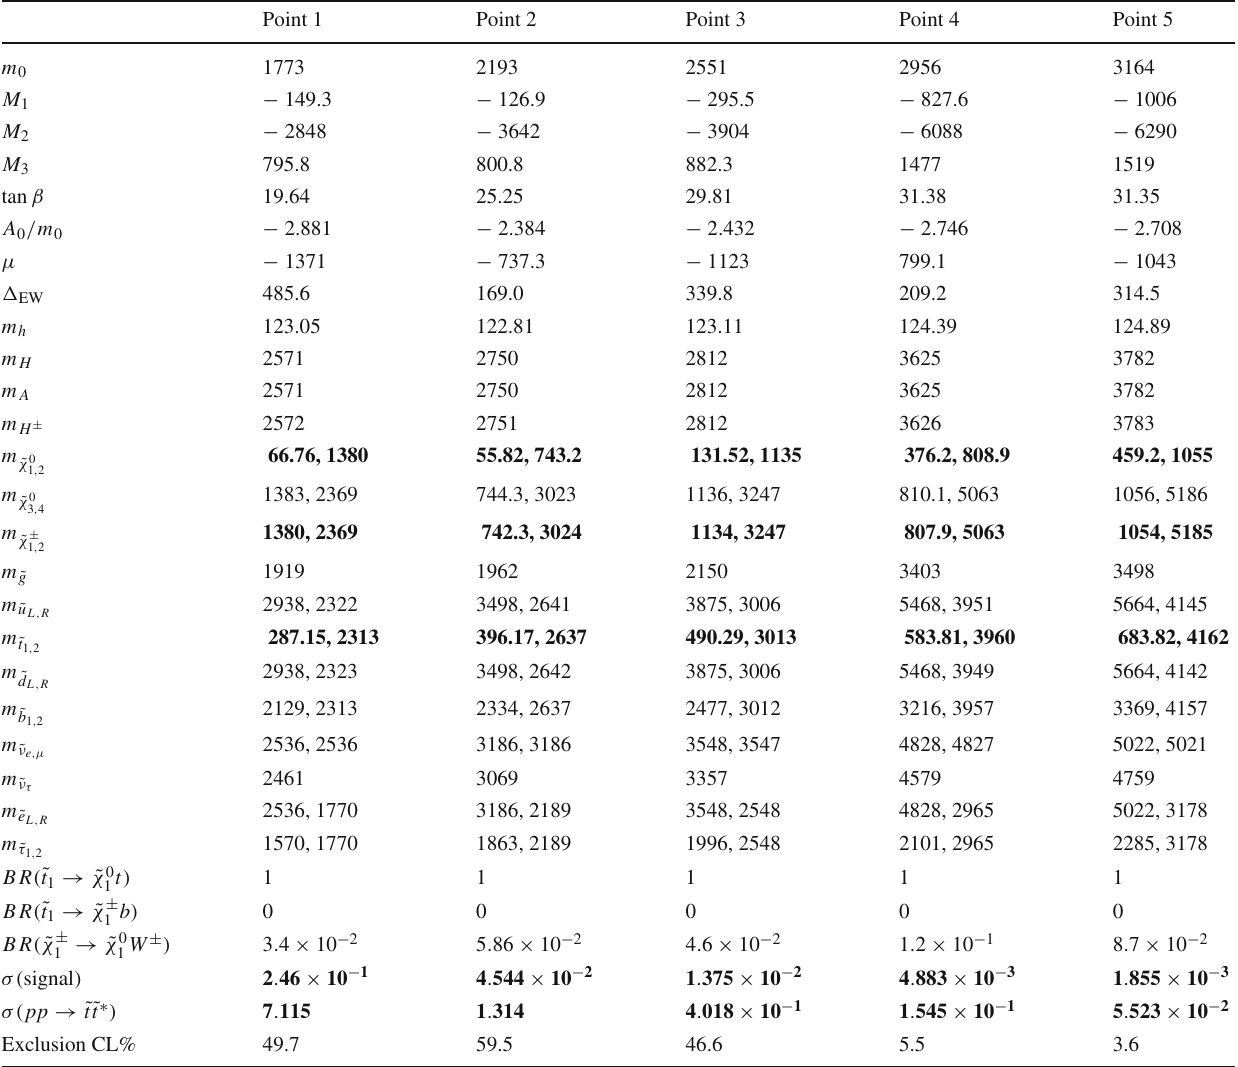
with several mass scales of the stop from about 287 to 683 GeV 1